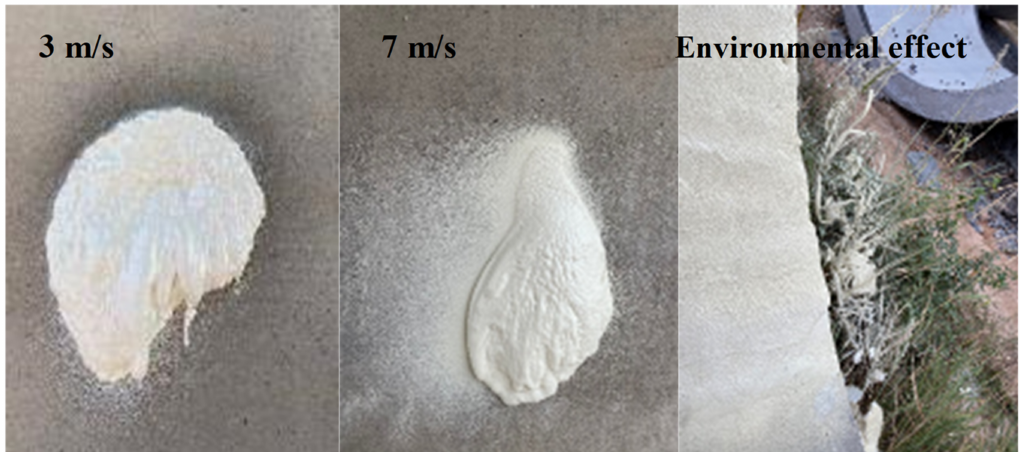
Figure 7. Polymer spraying performance at different v wind .